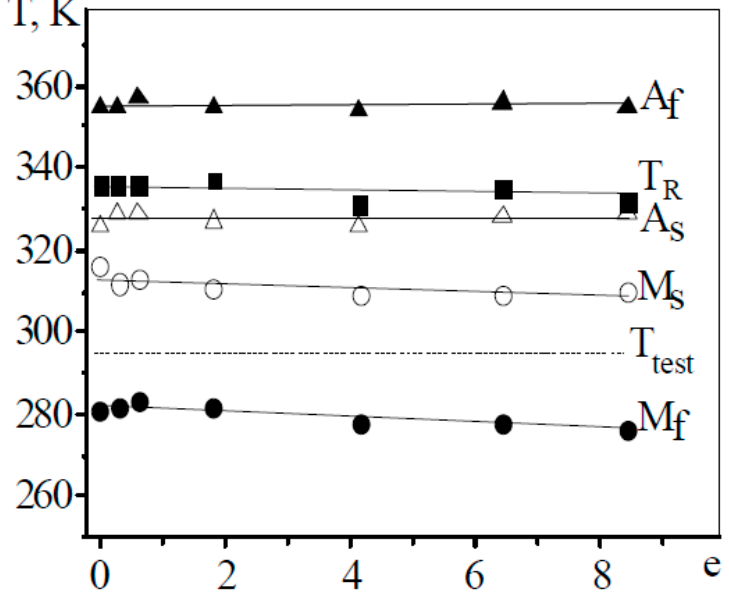
Figure 1. Martensite transformation temperatures versus true strain in Ti 49.8 Ni 50.2 after abc pressing.